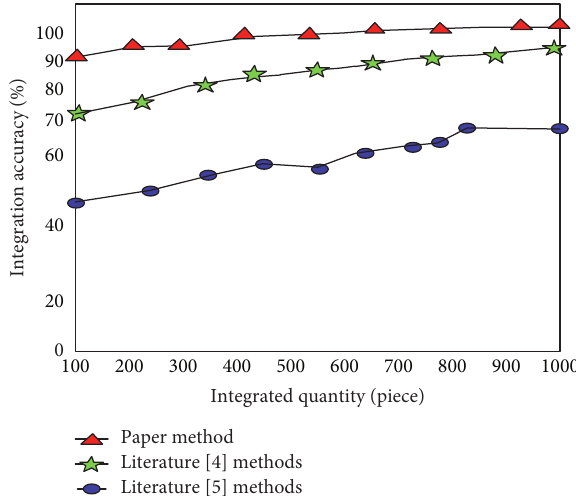
Figure 4: Integration accuracy results of sample data of different methods.